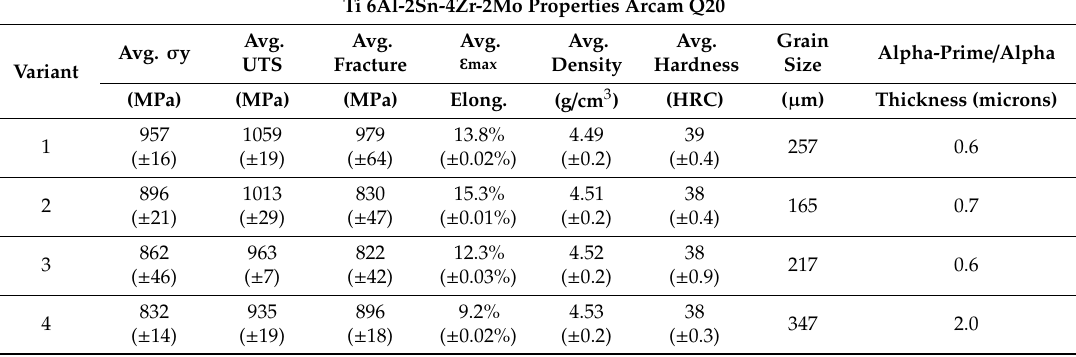
Table 3. Mechanical Properties of Ti 6Al-2Sn-4Zr-2Mo specimen variants built on an ARCAM Q20 system.